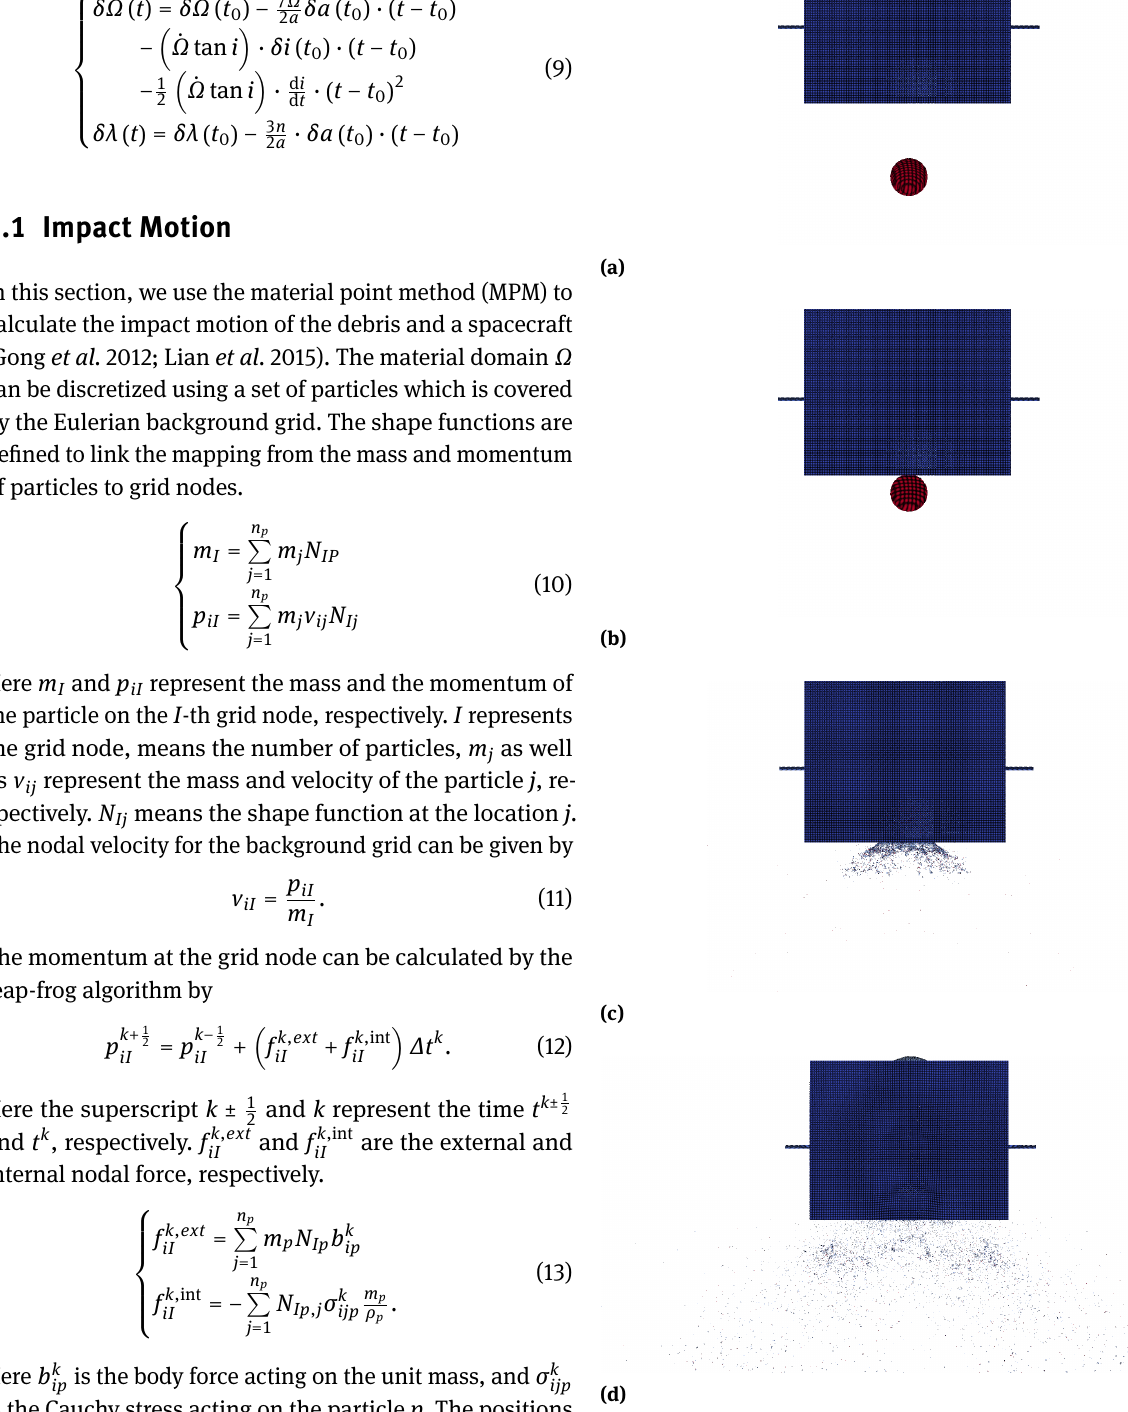
Figure 1. The impact process of the debris and the spacecraft. (a) the initial status, 0 ms; (b) 30 ms later; (c) 60 ms later; (d) 150 ms